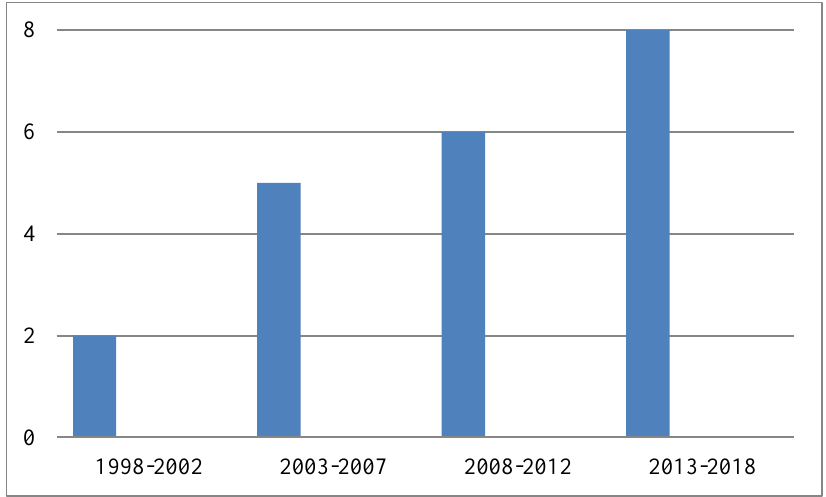
Figure 12. Degree of agreement among authors about the main types of accidents.“Source: Authors”